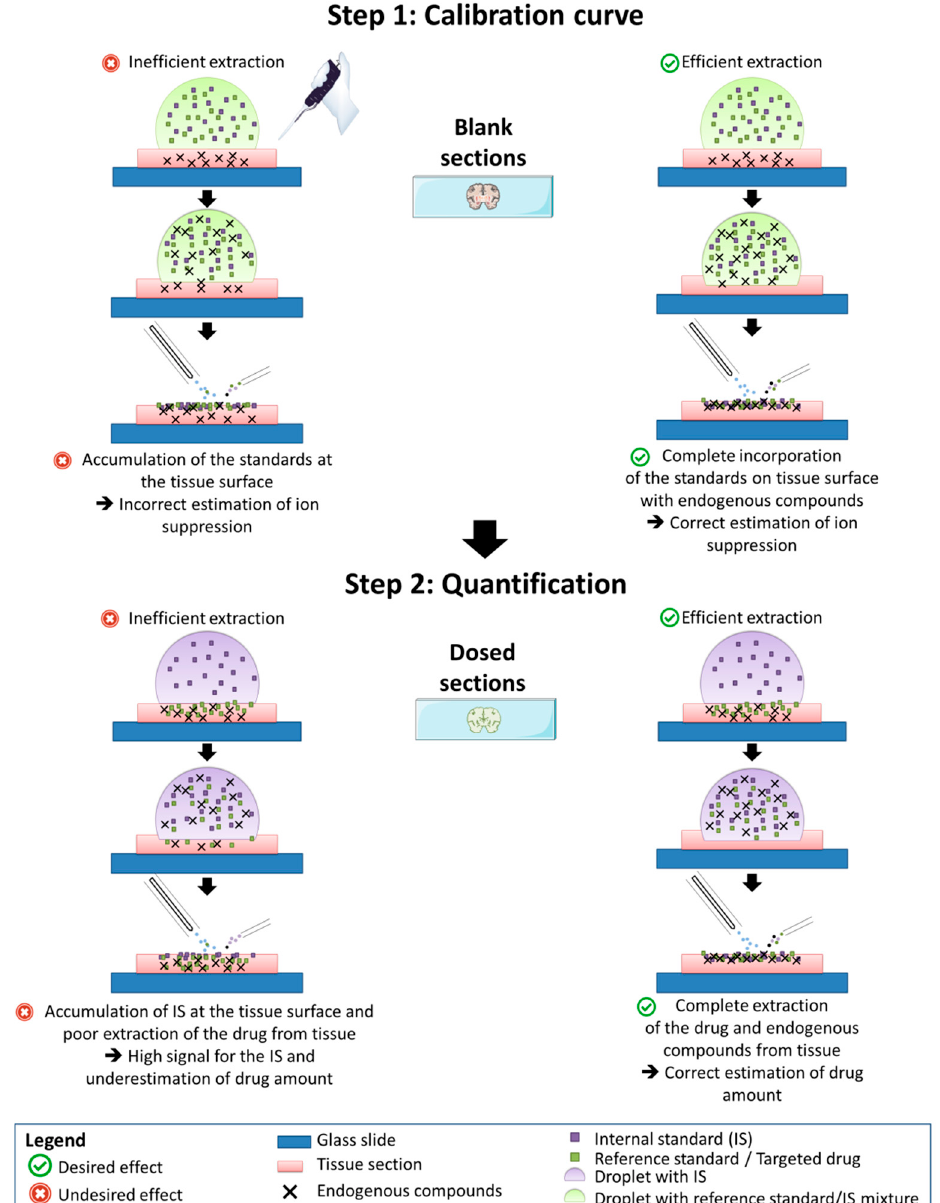
Figure 6. Possible artifacts during quantification of drugs from tissue sections induced by inefficient extraction.